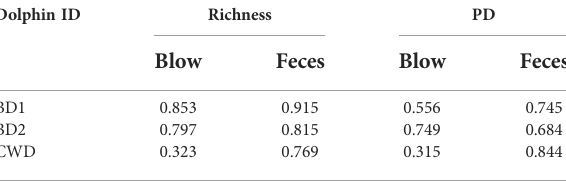
TABLE 1 The coef fi cient of variation of microbial diversity indices over one year in each dolphin. Dolphin